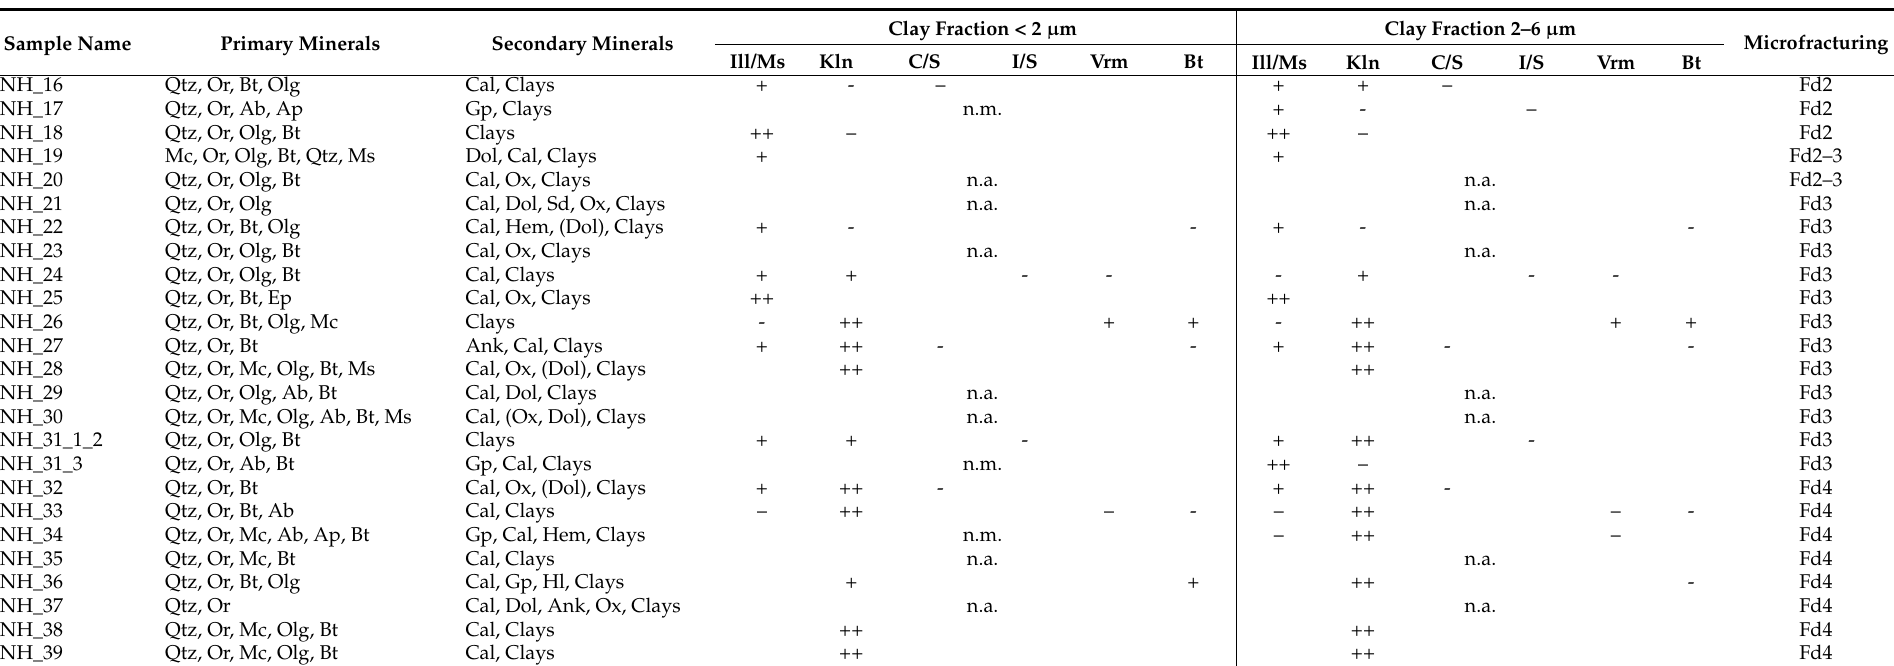
Table 1. List of samples collected in the field with their mineralogical composition determined after microscopic observations (optical-microscope and SEM-EDS) and XRD analysis (primary minerals and secondary minerals), their degree of microfracturing after [43], and their clay mineral composition for the fractions <2 µ m and 2–6 µ m. Abbreviations after [56], except for the following: Olg—oligoclase, Ox—oxide, I/S—illite/smectite, C/S—corrensite, n.m.—not measured, n.a.—not